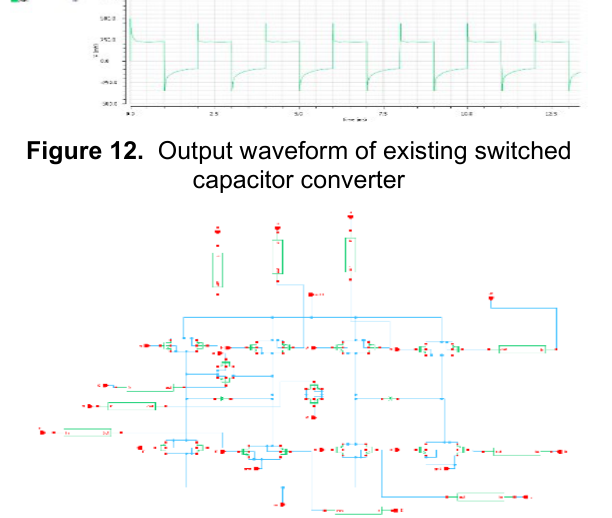
Figure 16. Output waveform of switched capacitor converter using Transmission Gate.